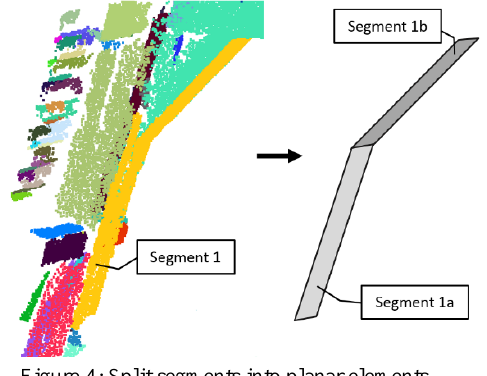
Figure 4: Split segments into planar elements